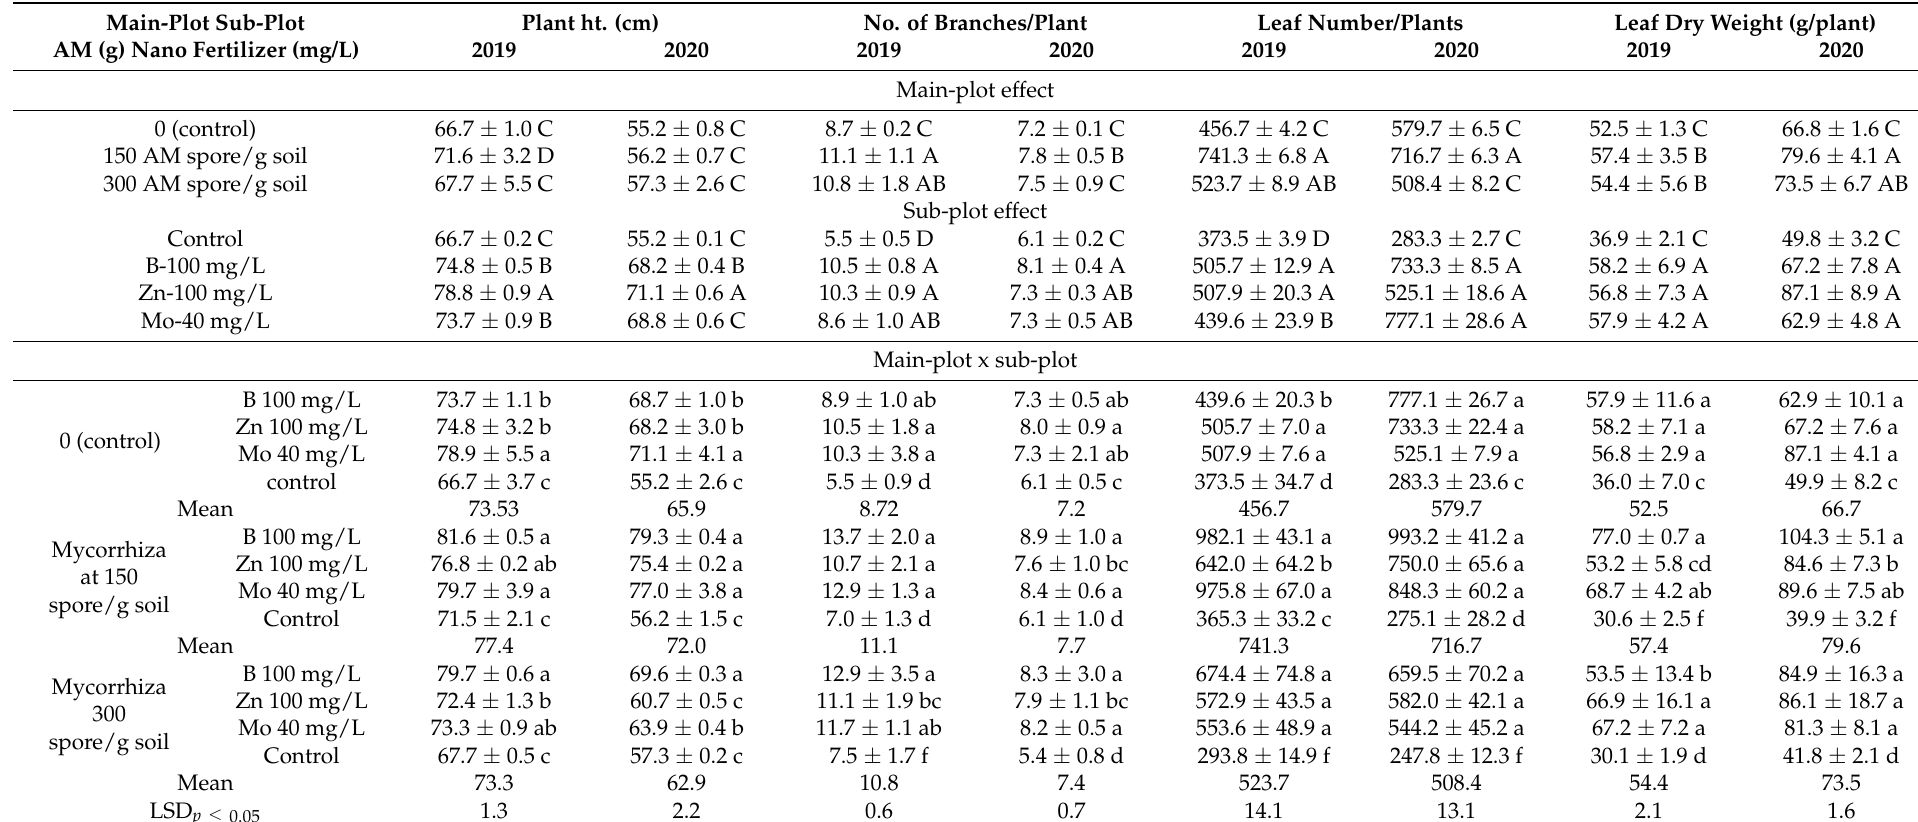
Table 1. Effect of arbuscular mycorrhiza (AM) and nano B, Zn, and Mo microelements on growth characteristics of stevia plants during 2019 and 2020 seasons. Main-Plot